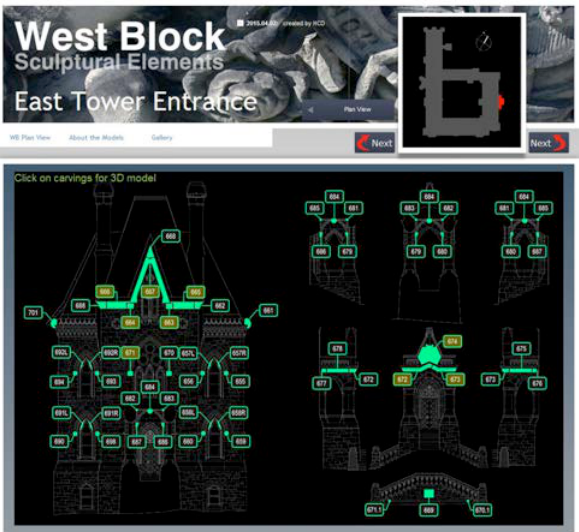
Figure 6. HTML graphic